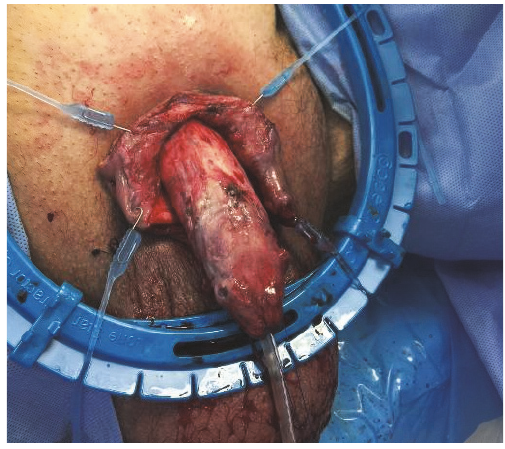
Figure3:Remainingtissueappearedviablefollowingdeglovingand debridement of the entire penis.